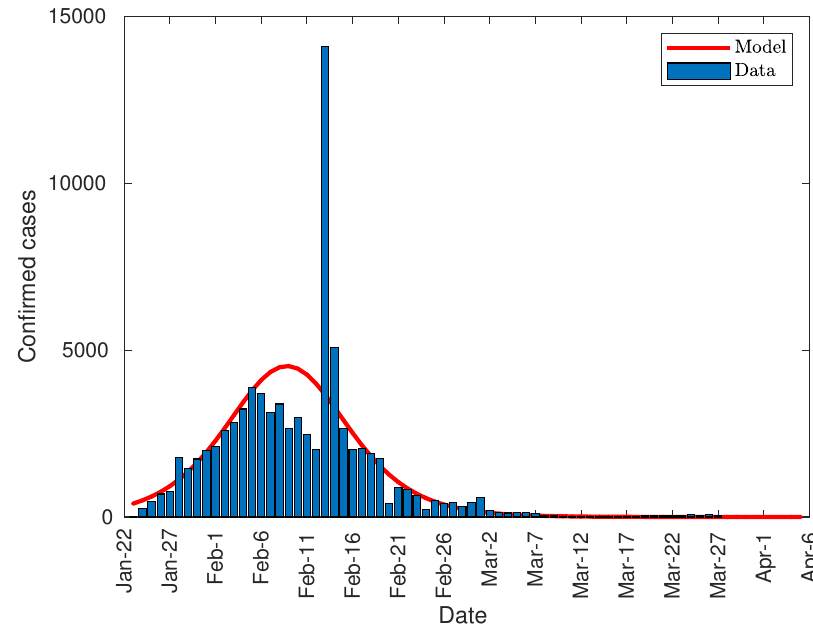
Figure 3. Number of daily diagnosed cases in